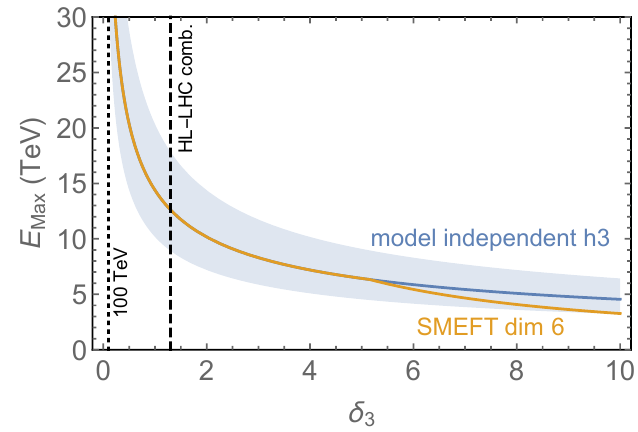
Figure 2 . The unitarity bound as a function of the deviation in the h 3 coupling. The optimal bound lies between the model-independent and SMEFT estimates. The band around the model- independent scale reflects the uncertainty of the bound from varying the unitarity constraint to ˆ 1 ≤ | M| ≤ 2 . For comparison, we show projected 95% C.L. limits on δ 3 from a combination at 2 HL-LHC and a 100 TeV pp collider from